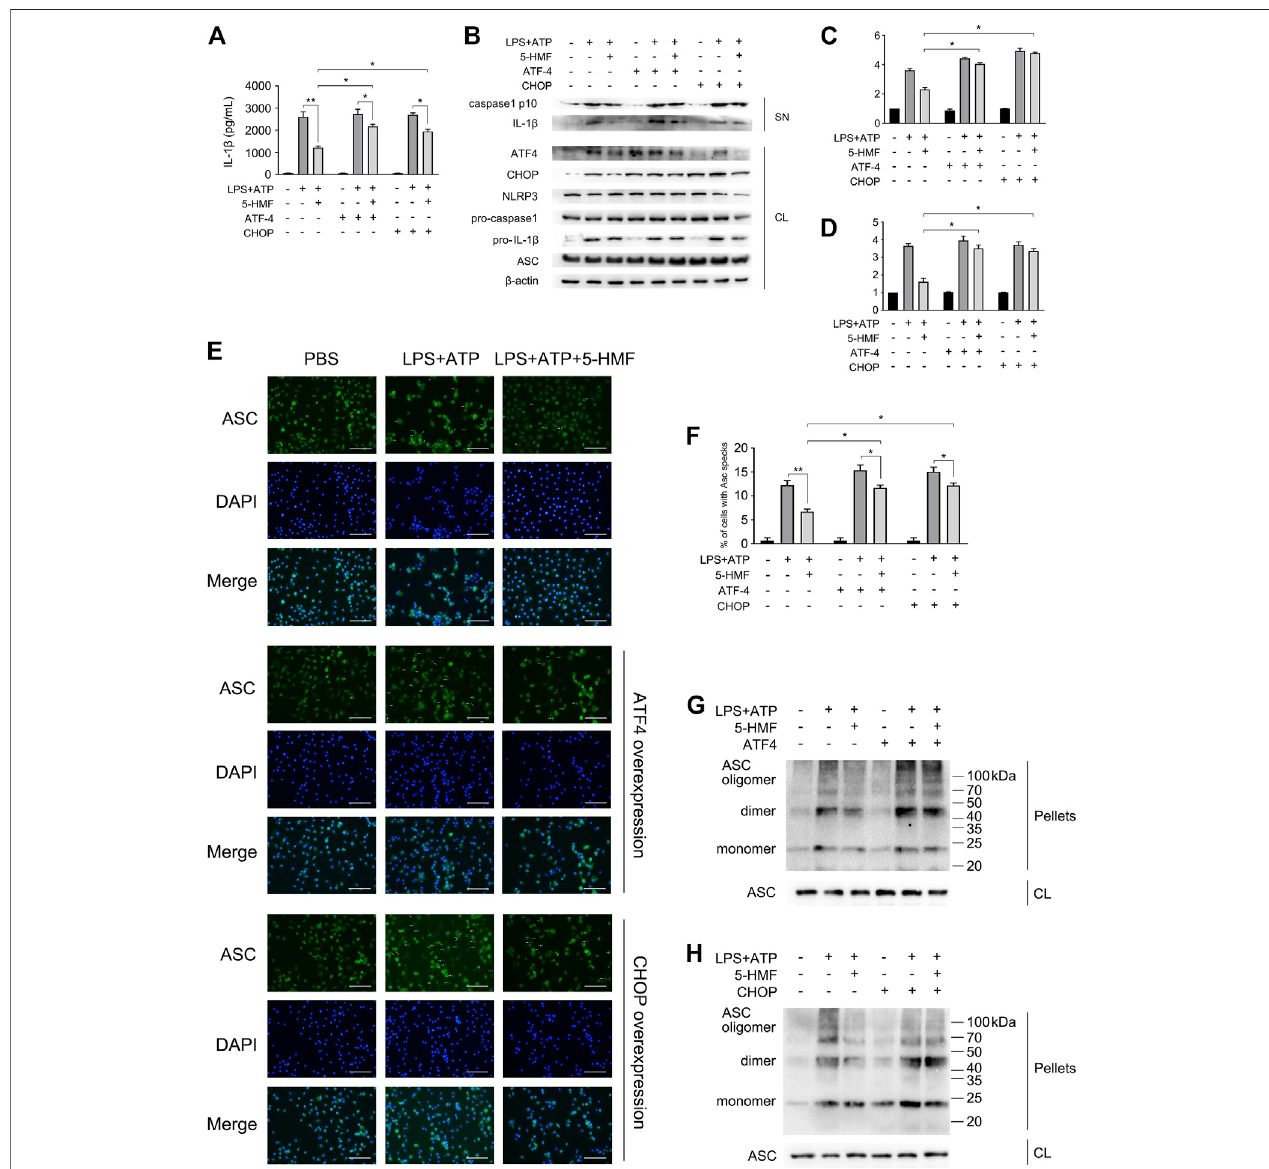
FIGURE 6 | 5-HMF inhibits NLRP3 in fl ammasome by down-regulating ER stress. BMDM were transfected with ATF4 and CHOP mRNA as indicated. After 48 h, cells were incubated with 5-HMF (50 μ g/ml) or PBS for 30 min, followed by LPS (500 ng/ml) for 6 h and ATP (5 mM) for 1 h (A) IL-1 β levels in culture supernatants. (B) Immunoblotshowinglevelsofindicatedproteinsintheculturesupernatants(SN)andcelllysates(CL). (C,D) TherelativebanddensitiesofIL-1 β (C) ,caspase-1p10 (D) in supernatant. (E) Representative immuno fl uorescence images showing ASC speck formation ( × 400), Scale bar, 500 μ m. (F) The percentage of cells containing ASC-specks in (E ). (G,H) Immunoblot showing ASC oligomerization in pellets cross-linked by DSS.